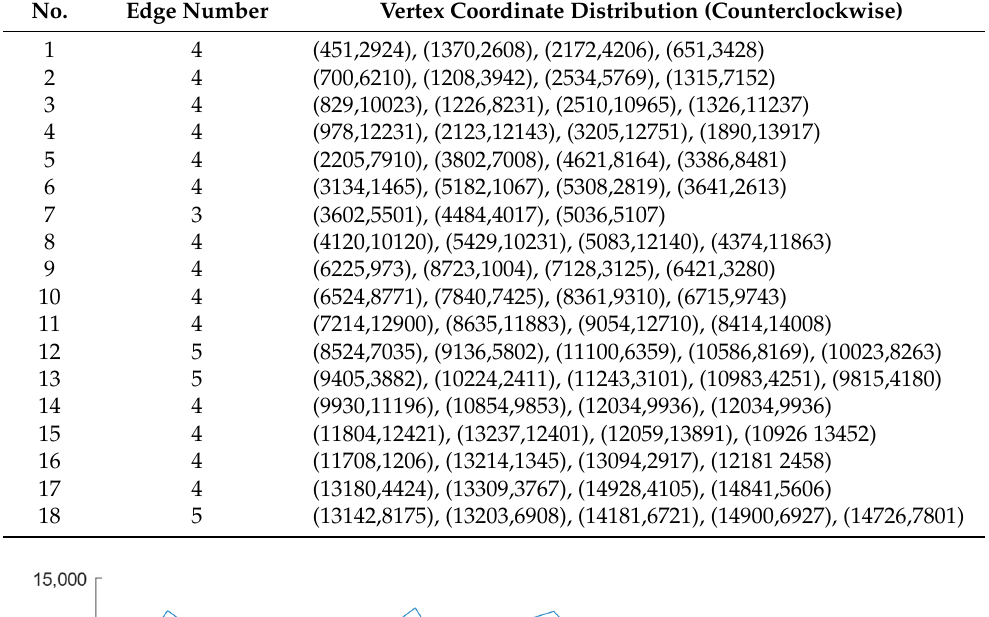
Table 1. The coordinates of the corresponding vertices.